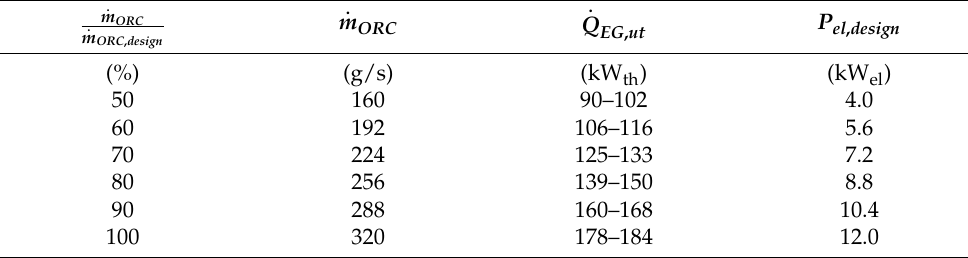
Table 1. Considered ORC operating